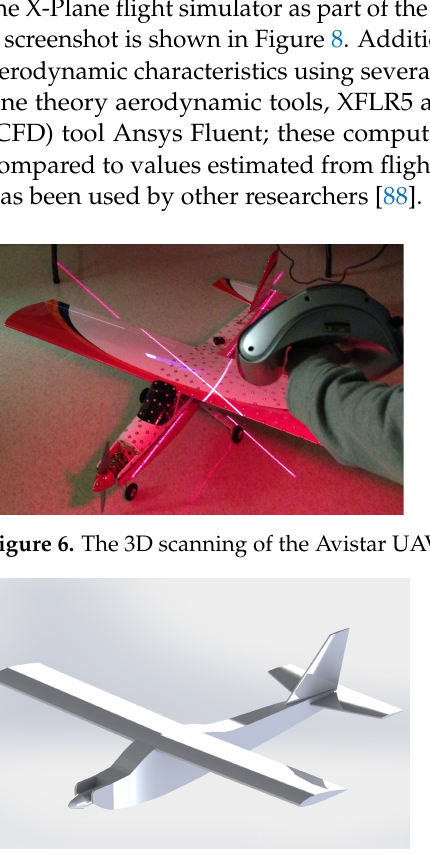
Figure 7. The SolidWorks CAD model of the Avistar UAV.